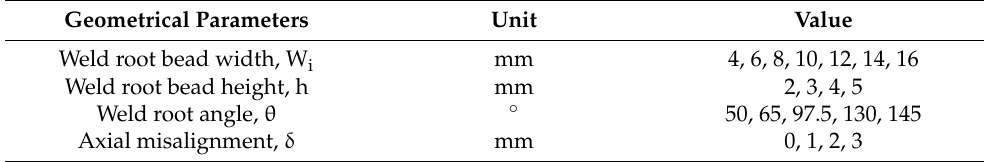
Table 3. Weld geometry of the single-sided girth weld.